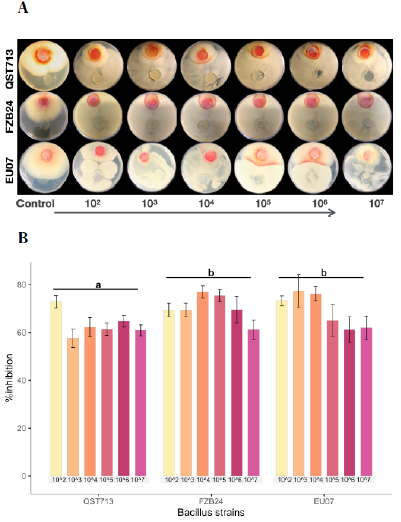
Figure 1. Dilution of Bacillus strains inhibits Fg -K1-4′s growth. ( A ) Dual culture experiment was set up on PDA/NA with Fg- K1-4 (reddish plugs) and the picture was taken 4d after incubation at 28 °C. ( B ) Percentage growth inhibition of Fg -K1-4 by the Bacillus strains with different dilutions. Data were from one independent experiment with four repeats shown and the mean ± SE were displayed. Experiment was replicated at least three times with similar results. Bars clusters with different letters were significantly different according to Tukey’s Test ( α < 0.05) following two-way ANOVA. n = 72.